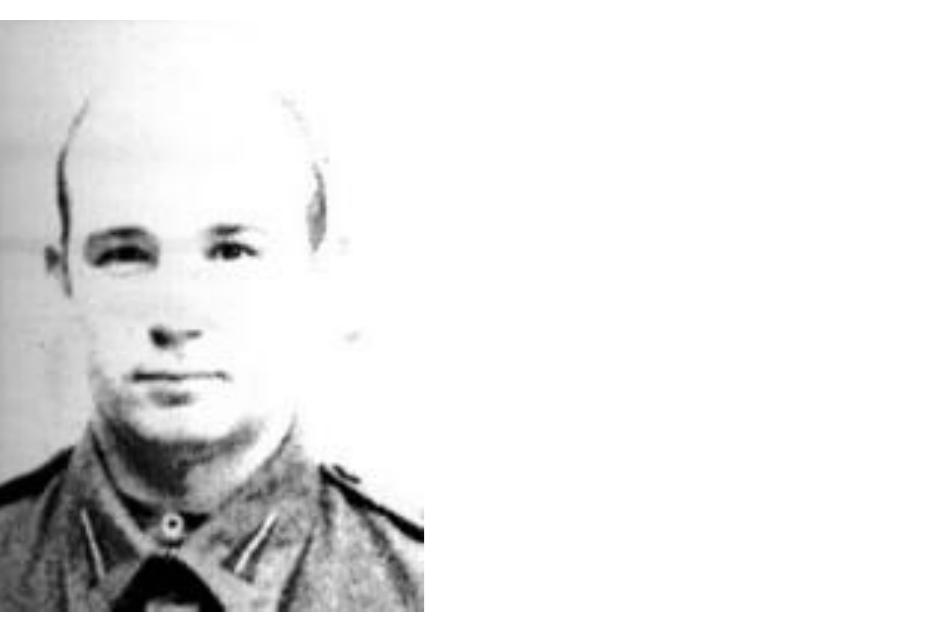
Figure 5. Jan Dusza, identified by the Polish Genetic Database of Victims of Totalitarianisms team, fallen on 14 August 1944.